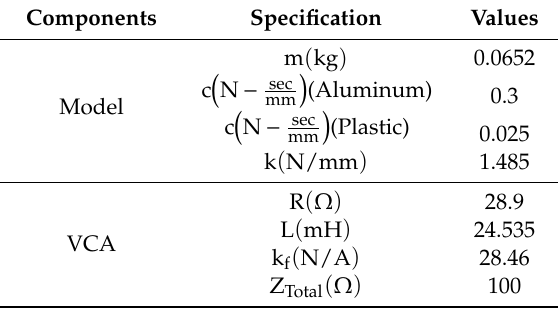
Table 2. Experimental system specification.